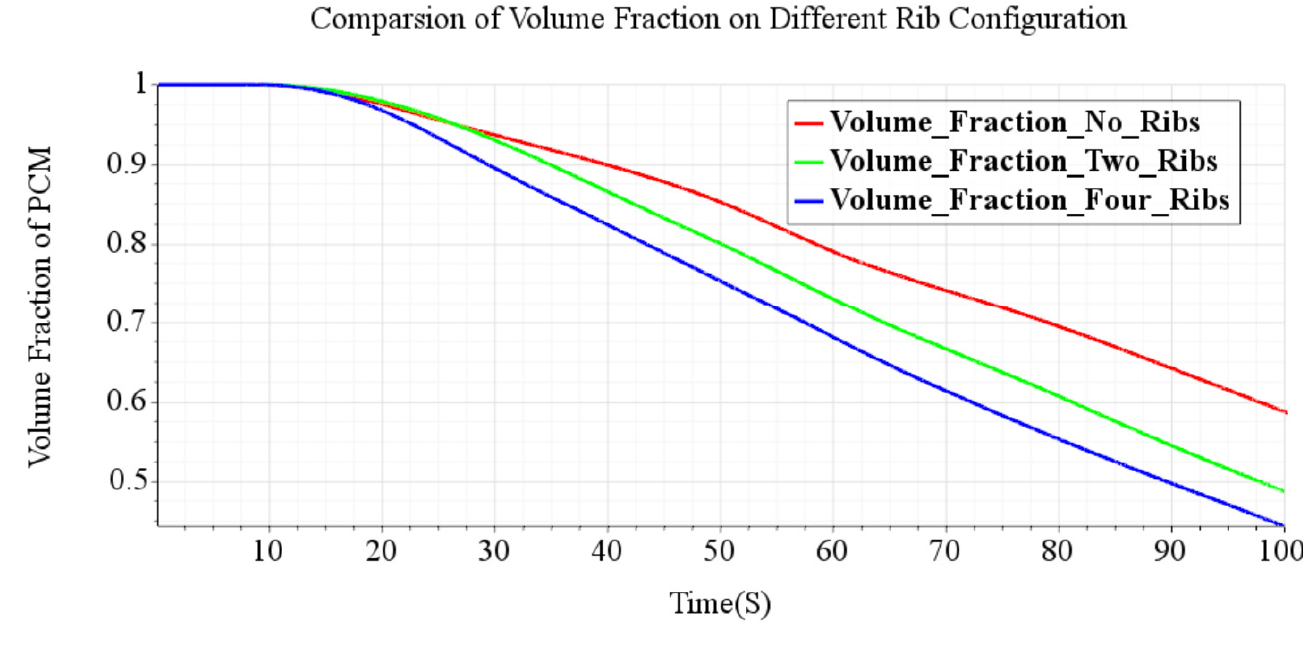
Figure 10. The volume change with function of time for different rib configuration.